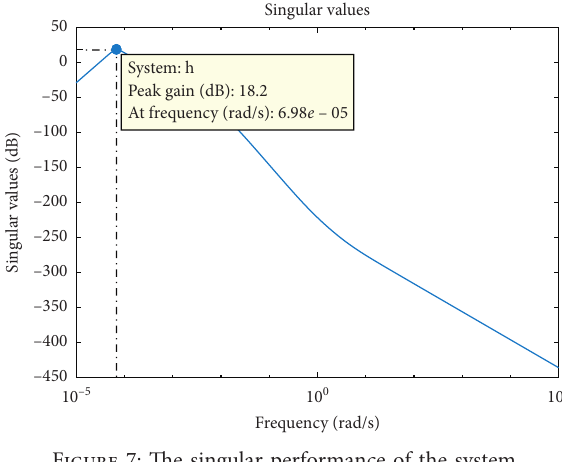
Figure 7: The singular performance of the system.